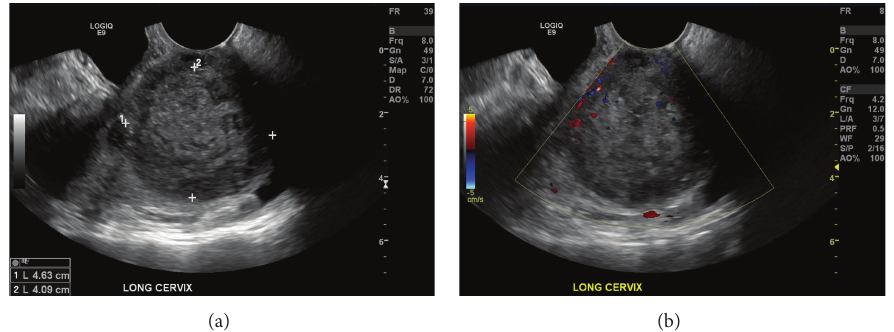
Figure 2: A transvaginal ultrasound. The gray-scale (a) and color Doppler images (b) demonstrate a large heterogeneously echogenic vascular mass measuring 4.6 × 4.1 × 3.6 cm, involving most of the